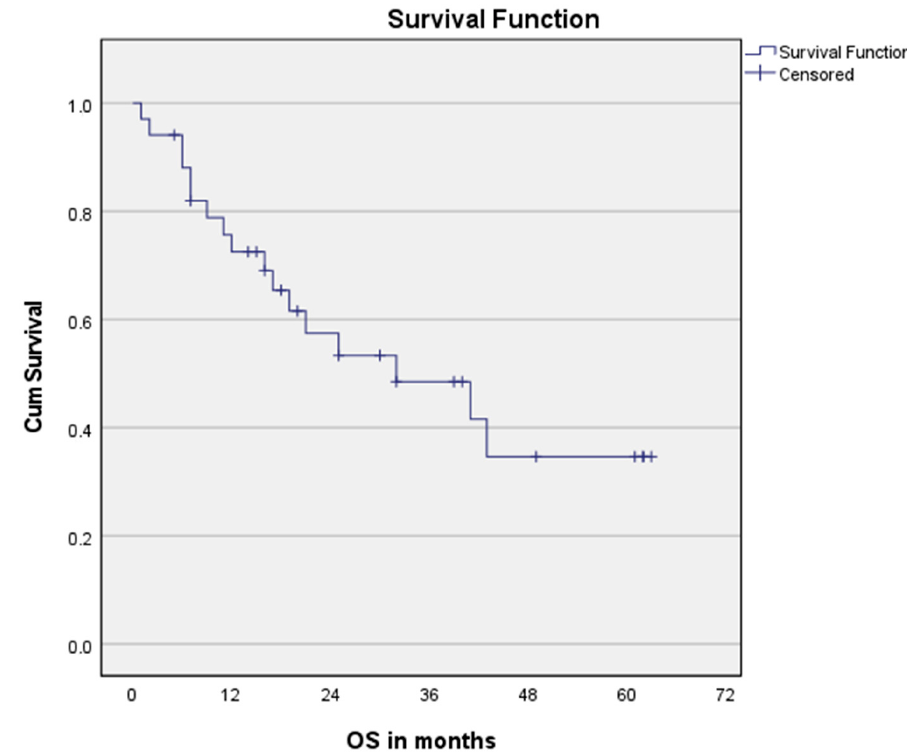
Figure 1. Overall survival for the entire cohort. n = 34.